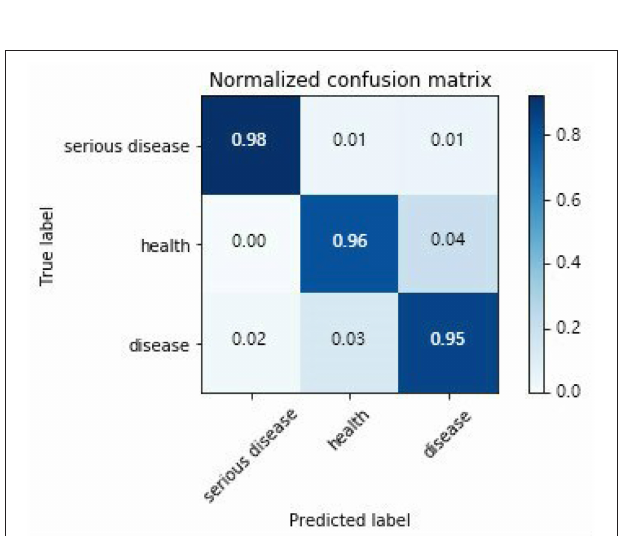
differentiating healthy subjects {OZ}, seizure-free intervals {FN}, and seizure activity {S} with a high ACC of 96.7% for one time.